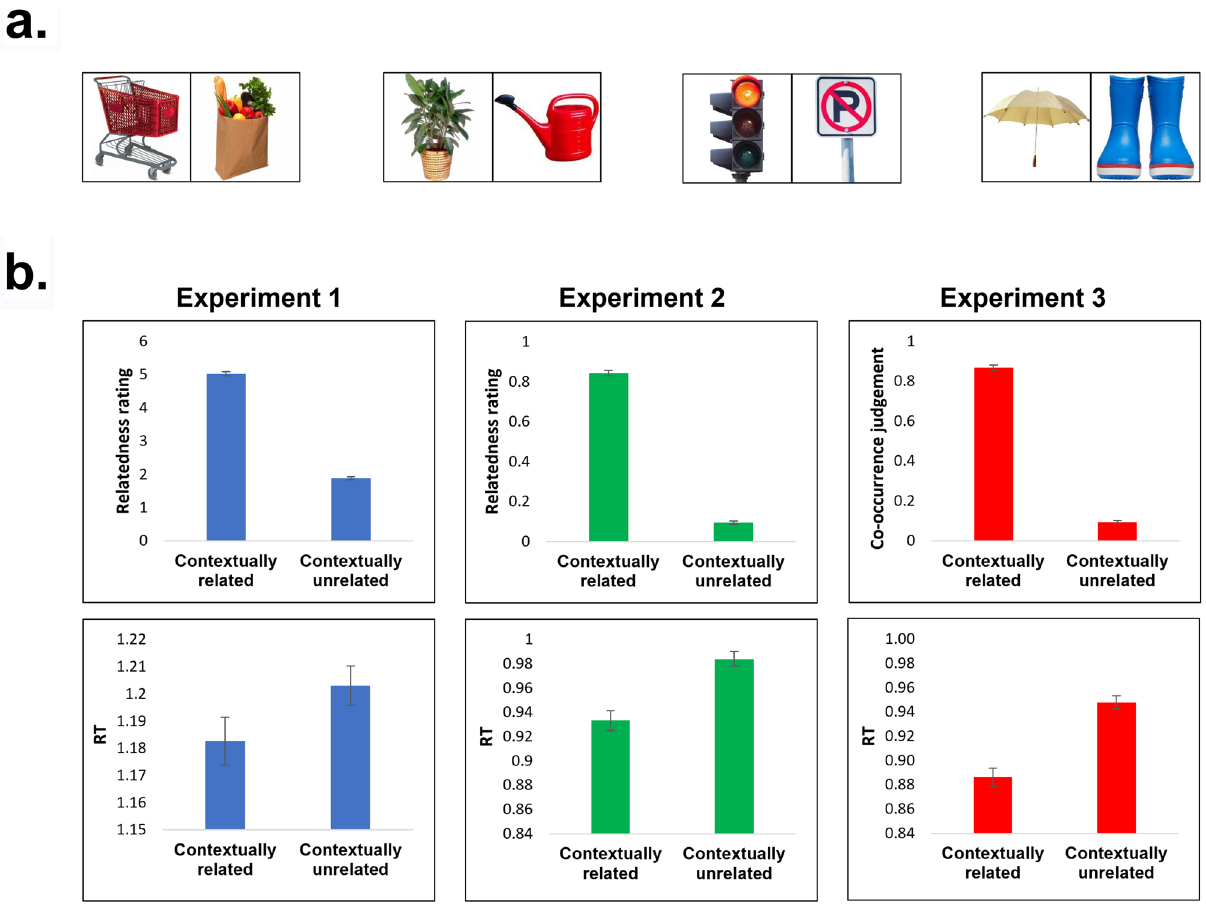
Figure 1. (a) Examples of the stimuli used. 73 contexts were chosen, each with 2 paired objects. All pictures were photographs of objects against a white background. ( b) Behavioral validation results. Three experiments were used to asses relatedness across contextually related object pairs. These experiments differed based on the instructions (Experiment 1 and 2 asked about relatedness; Experiment 3 asked whether the two objects would be found in the same picture); and the response choice (Experiment 1 used a rating scale of 6 points; Experiments 2 and 3 used a two alternative forced choice), see Methods. Across these three experiments, contextually